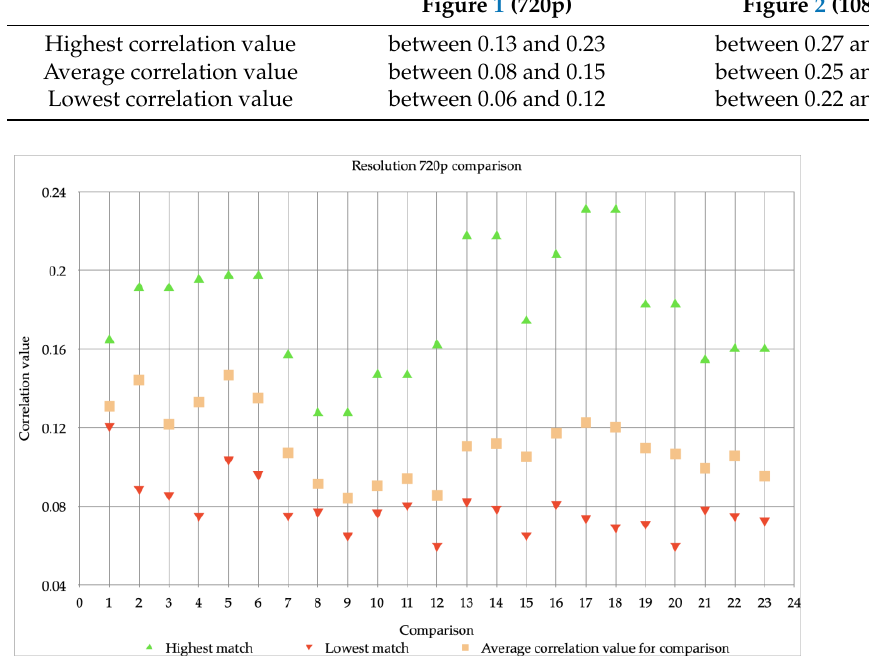
Figure 1. 23 comparisons, done with images made with an iPhone 6, all with a resolution of 720p.